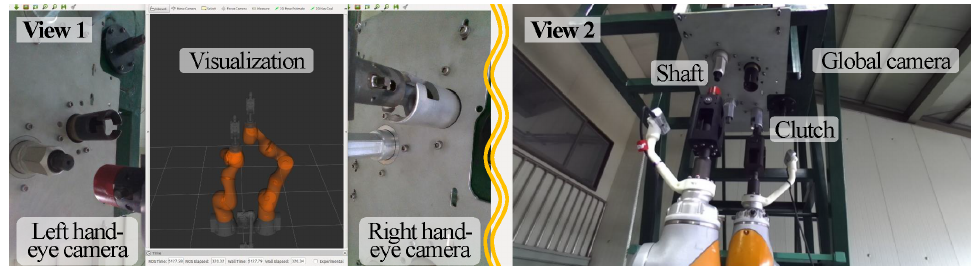
Figure 6. Teleoperation experiments were performed while viewing the hand-eye camera images (view 1 on the left), attached to the left and right robots, and global camera images (view 2 on the